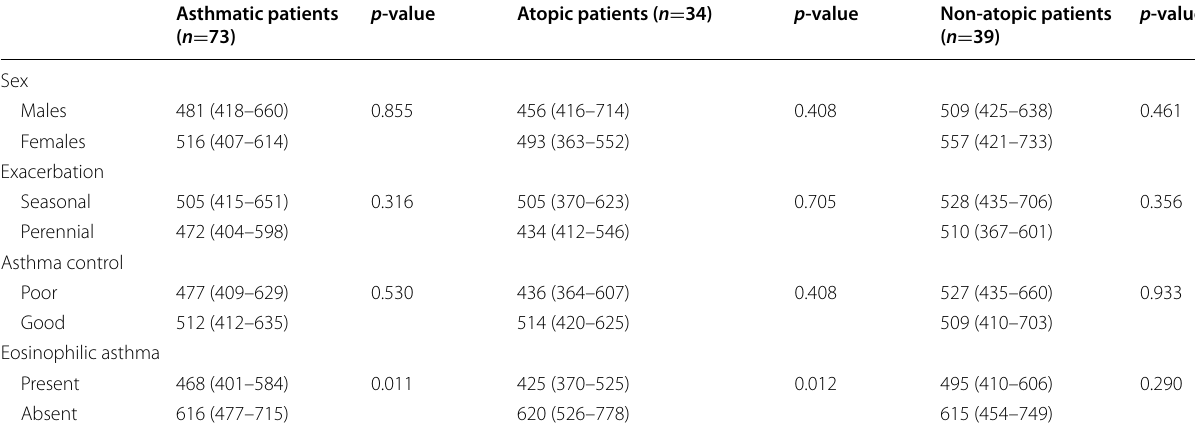
IL-38 serum levels are presented as median (interquartile